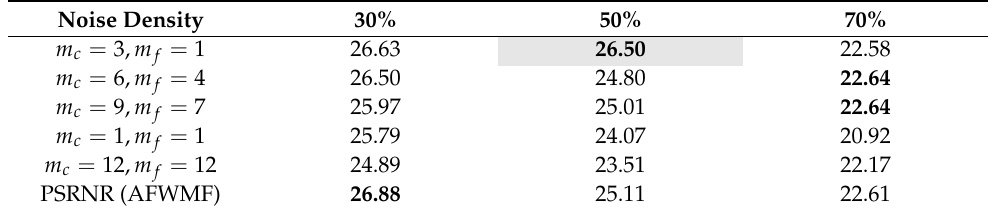
Table 14. The PSNR value for setting parameters by referring to the PSRNR formula (Boat image). Noise Density